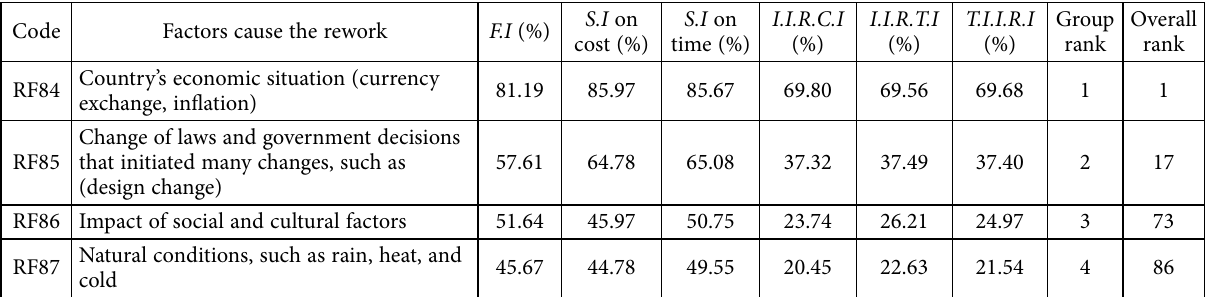
Table 13. Ranking the causes and impact of rework factors related to external